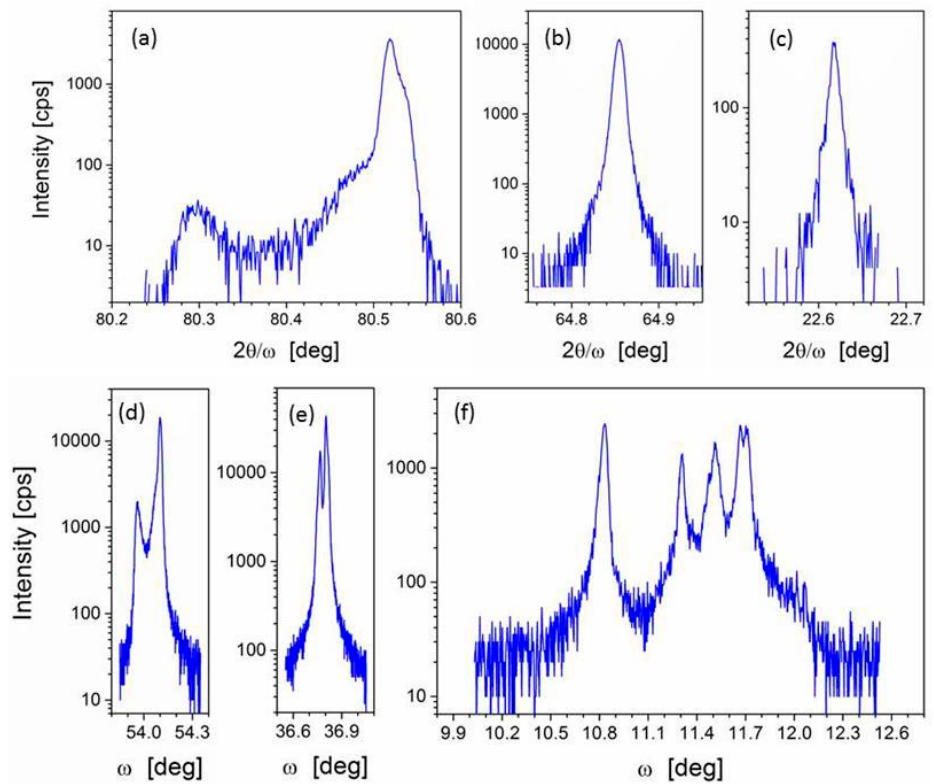
Figure 3. Logarithmic intensity scale 2 θ / ω and ω scans for 600 reflection of Ca 3 Y 2 (BO 3 ) 4 ( a and d , respectively), 006 reflection of Ca 3 Gd 2 (BO 3 ) 4 ( b and e , respectively), 040 reflection of Ca 3 Nd 2 (BO 3 ) 4 ( c and f , respectively). The logarithmic scale strongly enhances the minor effects of secondary grains and compositional inhomogeneity observed in Ca 3 Y 2 (BO 3 ) 4 (left), and Ca 3 Gd 2 (BO 3 ) 4 .